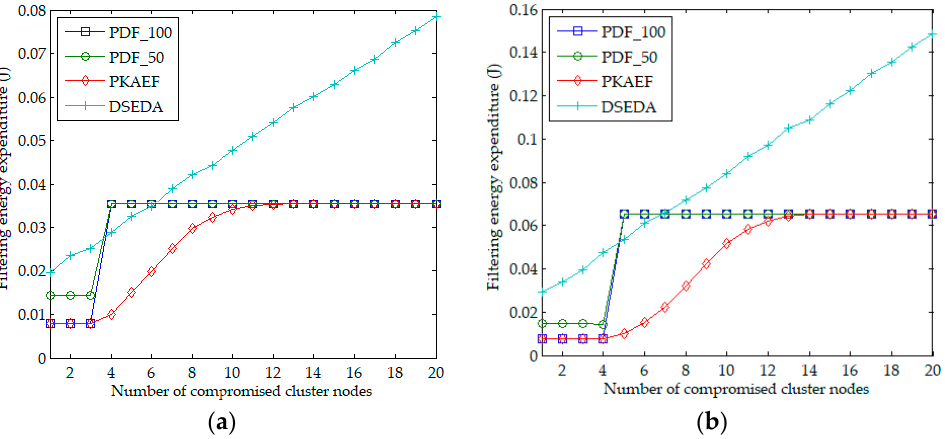
Figure 4. Filtering energy expenditure as a function of the number of compromised cluster nodes. ( a ) in Scenario 1; ( b ) in Scenario 2.